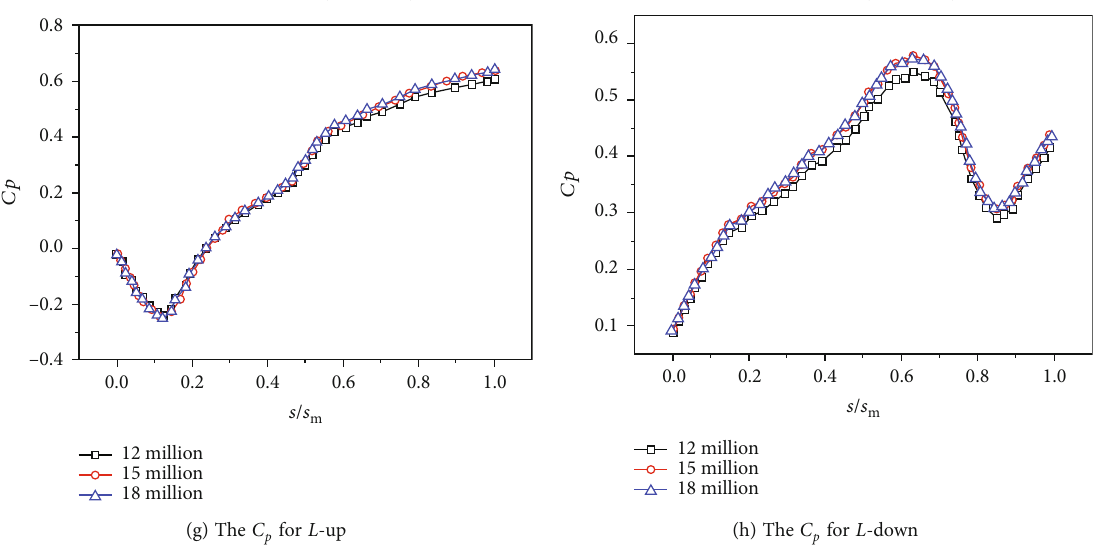
Figure 2: Mesh for the numerical